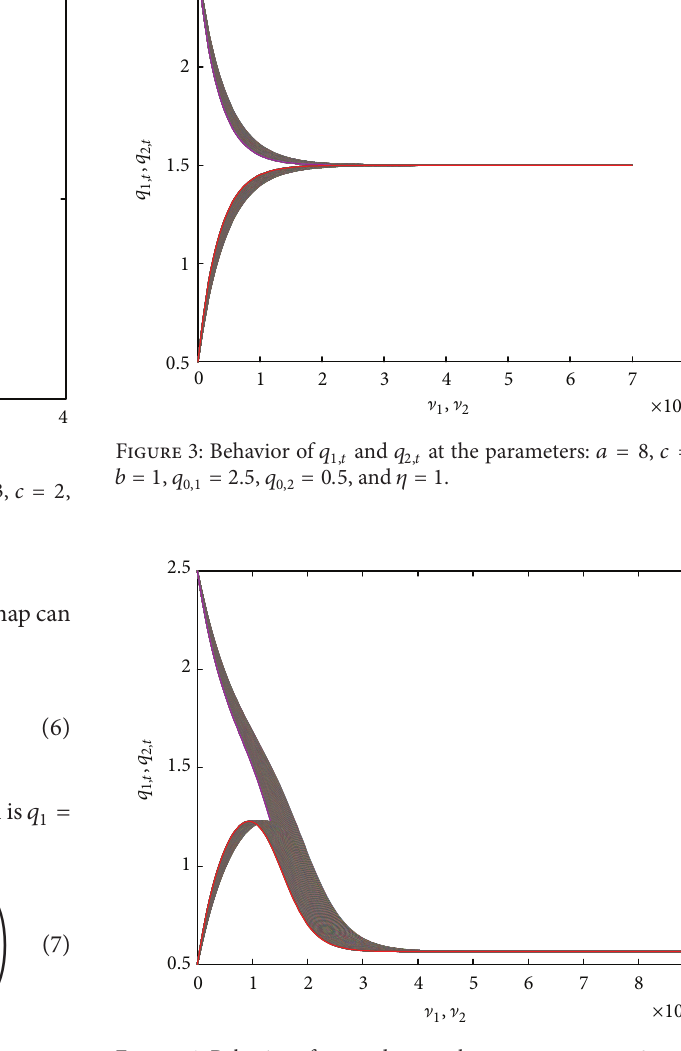
Figure 4: Behavior of 𝑞 1,𝑡 and 𝑞 2,𝑡 at the parameters: 𝑎 = 8 , 𝑐 = 2 , = 2.5 , 𝑞 = 0.5 , and 𝜂 = 1.3 𝑏 = 1 , 𝑞 0,1 0,2